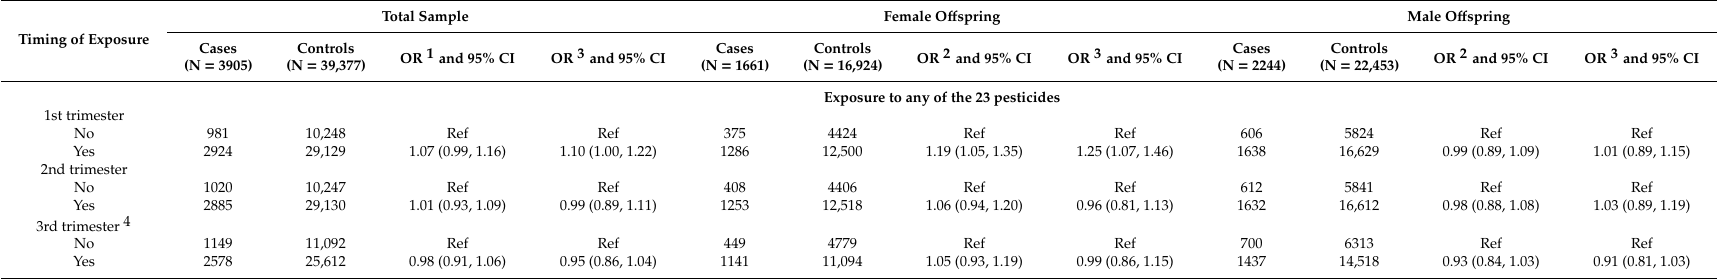
Table 2. Odds Ratio (OR) and 95% confidence interval (CI) for cerebral palsy according to pregnancy exposures to the 23 pesticides compounds and suspected endocrine